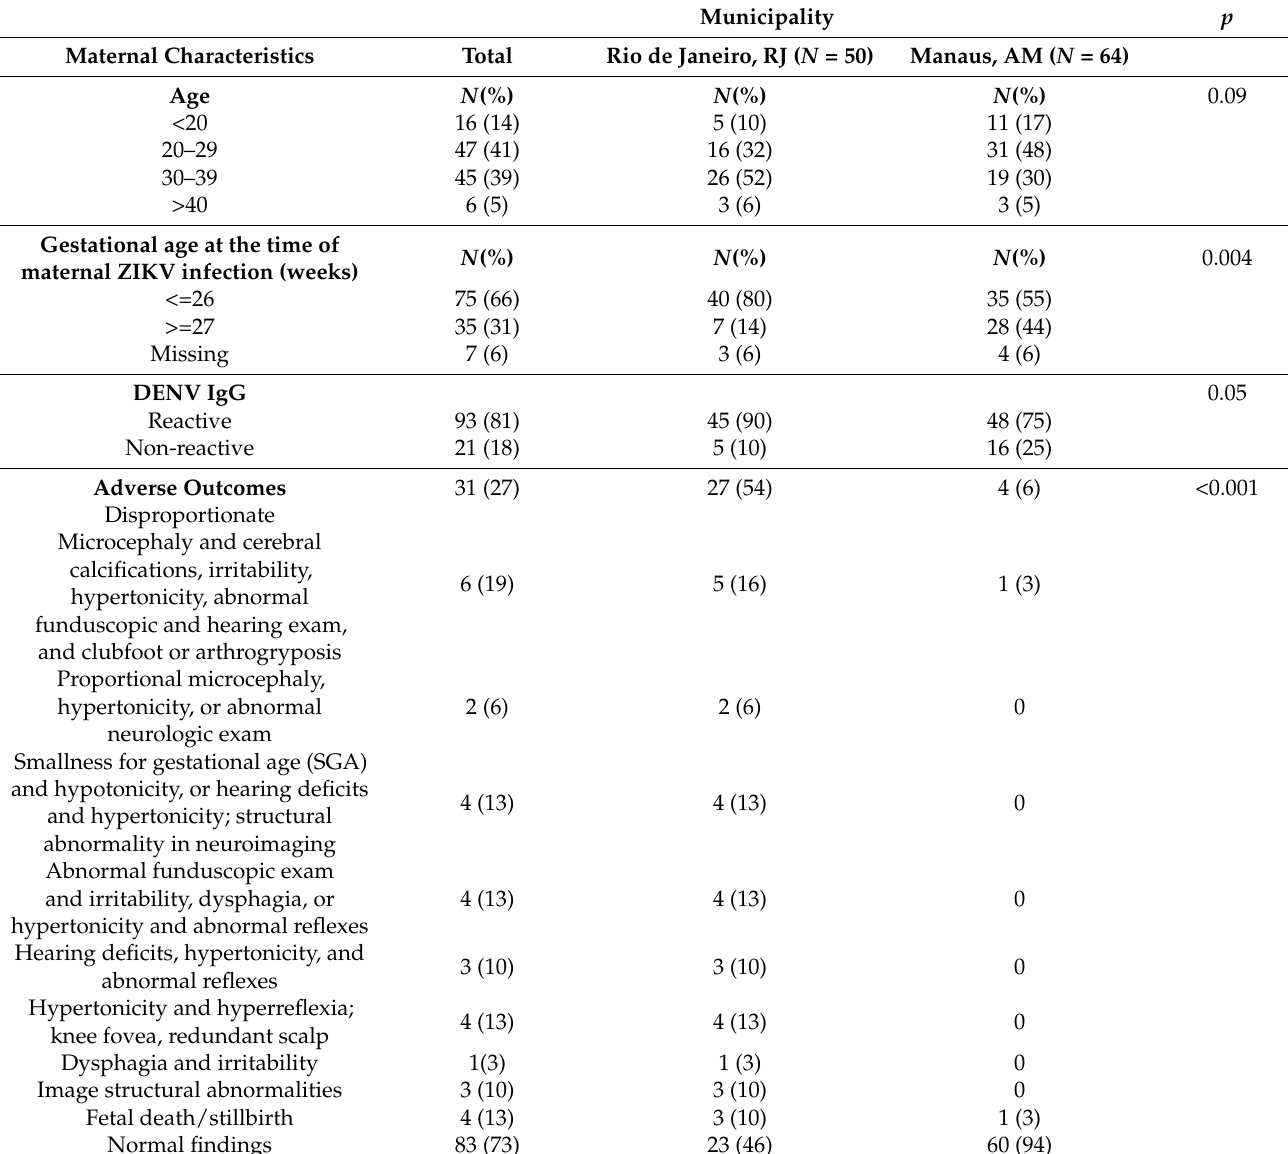
Table 1. Maternal characteristics and infant outcomes stratified by municipality.